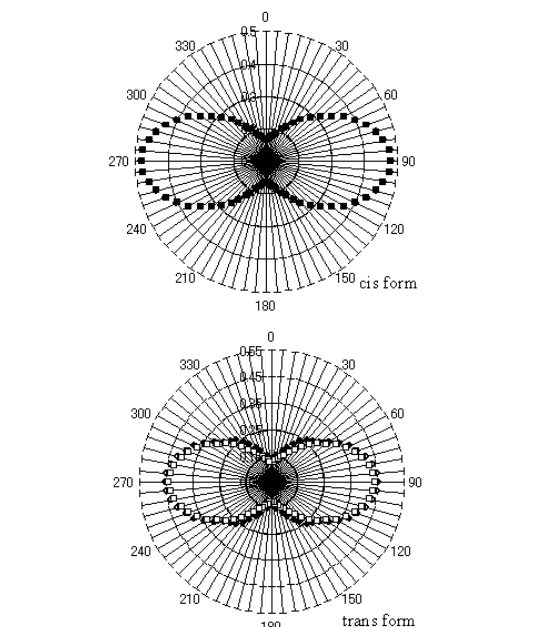
Figure 8. Circular diagram for PMMA-AZ ϖ - ϖ * at 318 nm for [above] cis form (filled circle for initial, empty circle for UV after 10 cycles, and filled square for UV after 20 cycles), [below] trans form (filled circle for initial, empty circle for visible after 1 cycle, filled square for visible after 10 cycles, and empty square for visible after 20